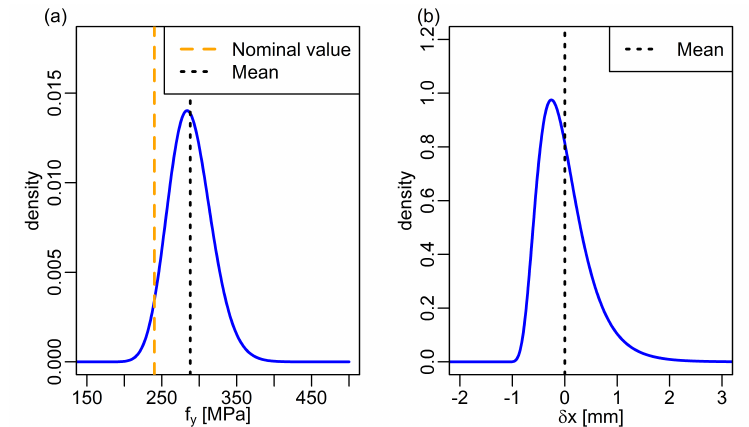
Figure 4. Models for important sources of uncertainty. ( a ) Probability distribution of yield strength. Both the nominal value (orange) and the actual mean (black) are indicated. ( b ) Probability distribution of manufacturing